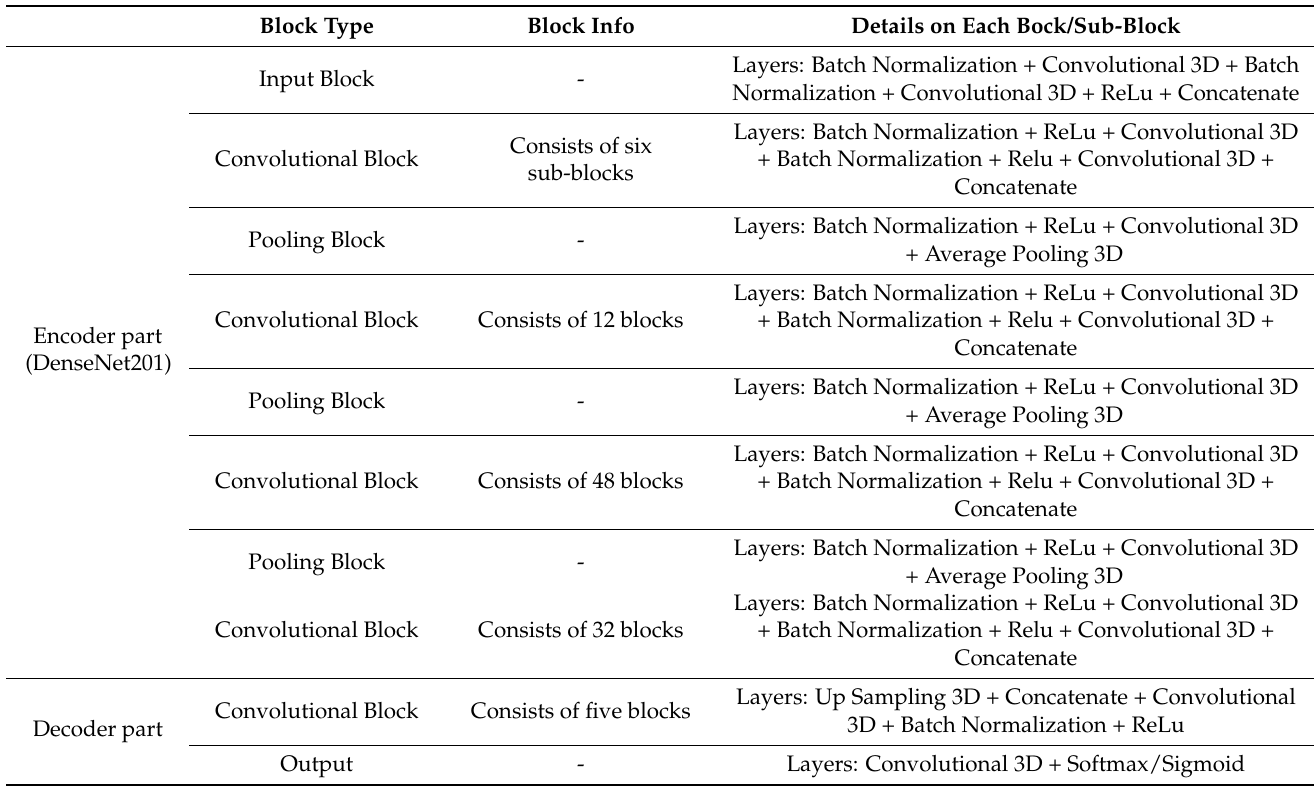
Table A3. Details on 3D DenseUNet